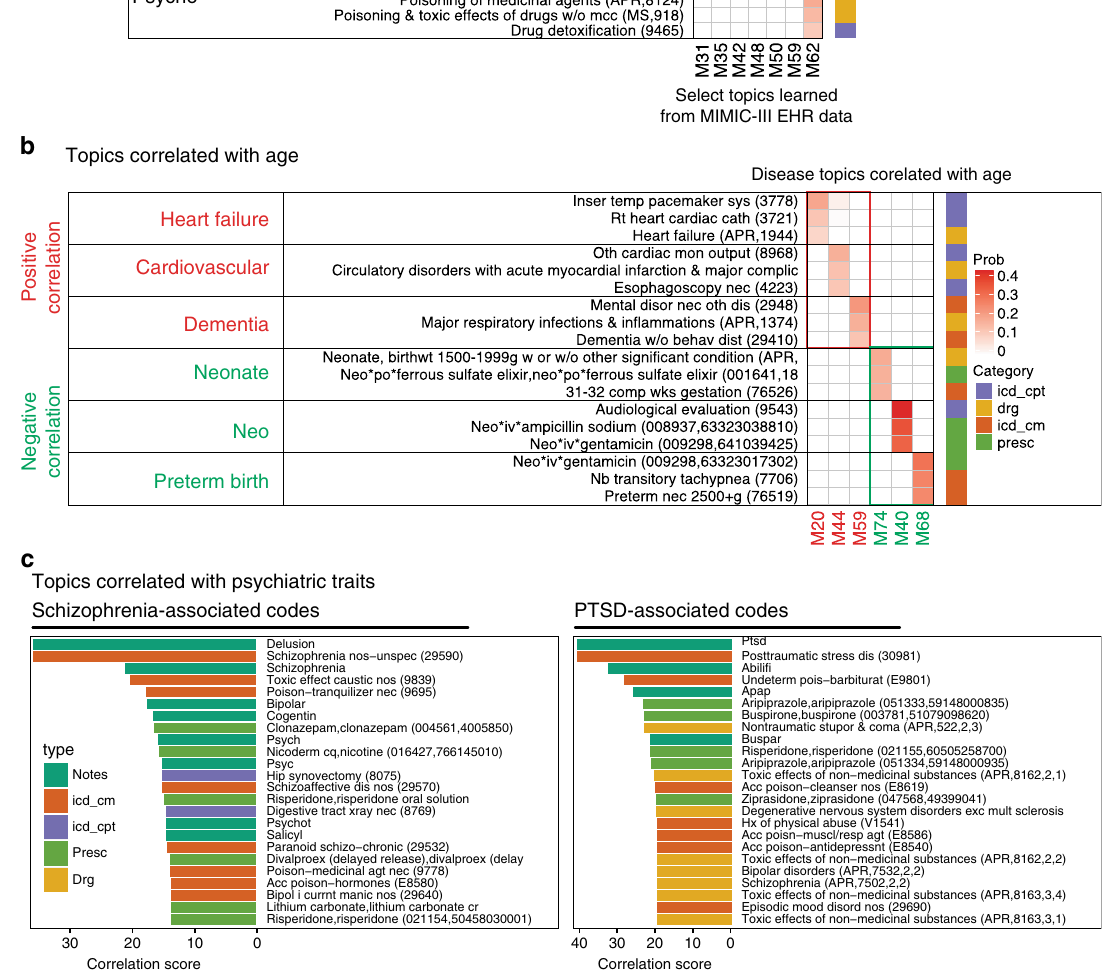
Fig. 2 Disease topics from MIMIC-III dataset. a Top fi ve EHR codes for select disease topics from the 75-topic MixEHR model. The rows are the top features, and columns are the topics. The color intensities indicate the inferred probabilities of these features belonging to each topic. b Age-correlated disease topics. Top three EHR codes were displayed for the top three most and least age-correlated topics. c Top correlated EHR codes with schizophrenia and